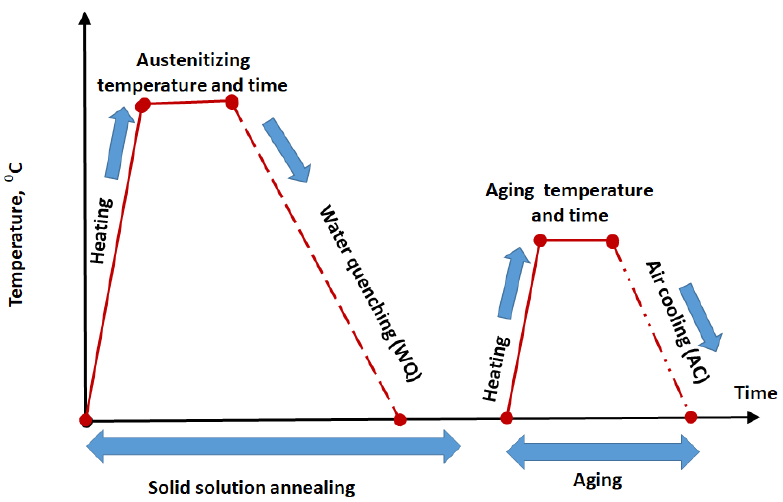
Figure 1. Heat treatment cycle of investigated steel samples.